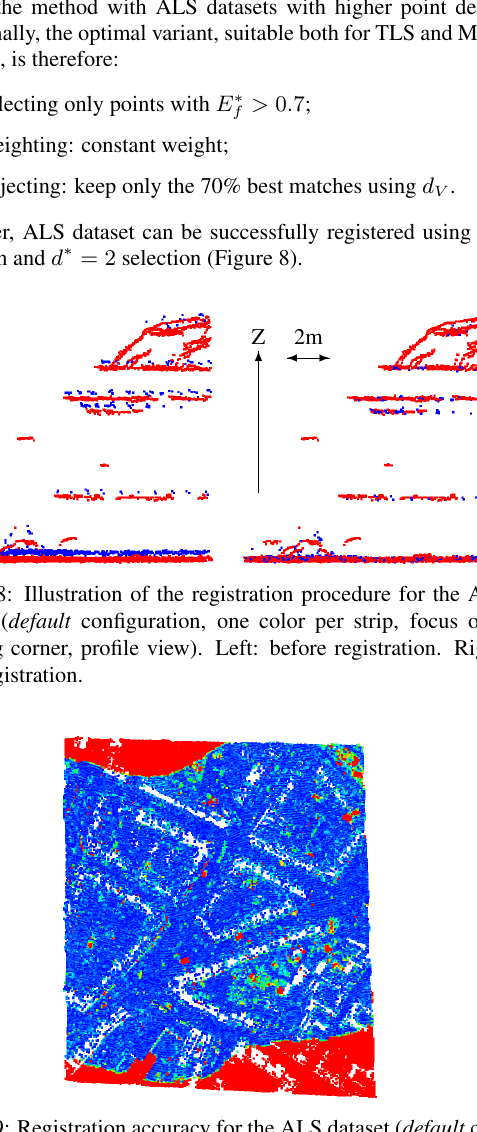
Figure 9: Registration accuracy for the ALS dataset ( default con- figuration), colored according to ¯ t (0 m (blue) → 5 m